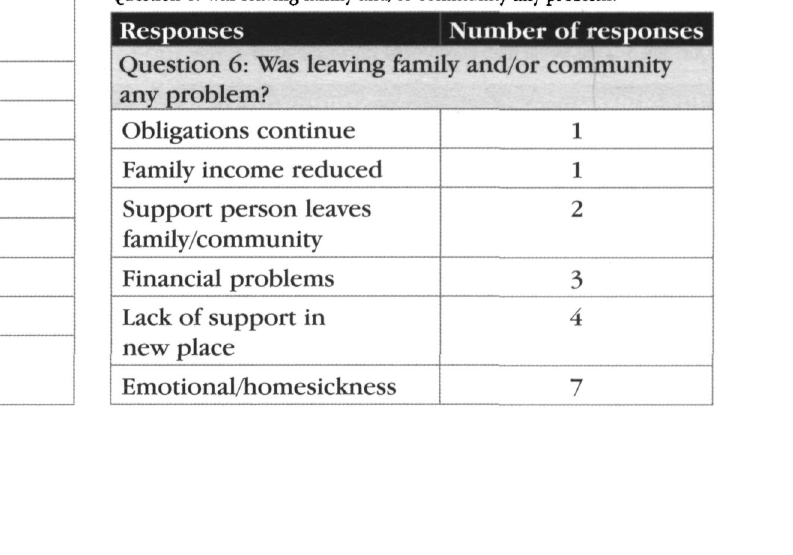
Table 6: The responses of withdrawn Indigenous medical students to Question 6: Was leaving family and/or community any